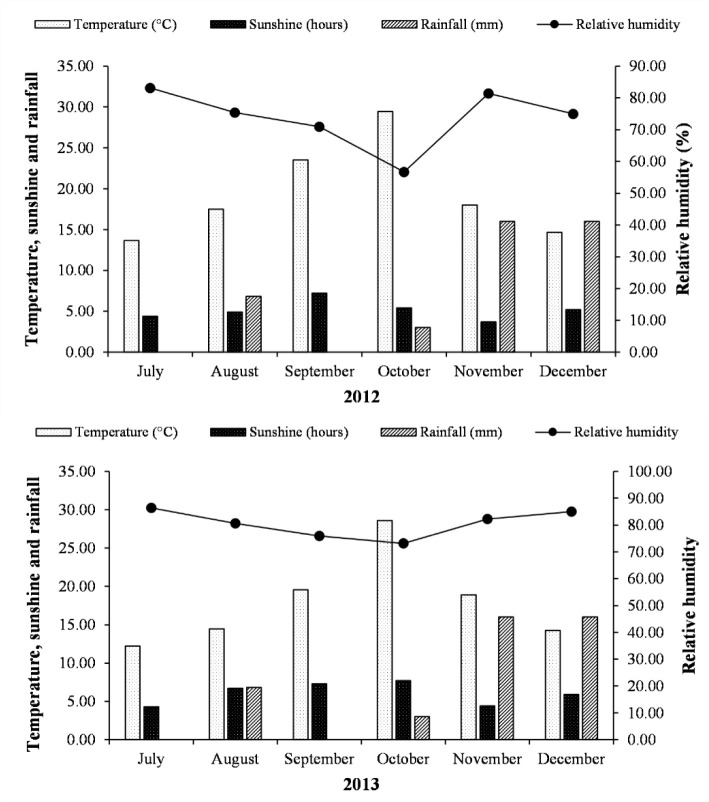
Climatic data of the experimental site during cotton growing seasons of 2012 and 2013.